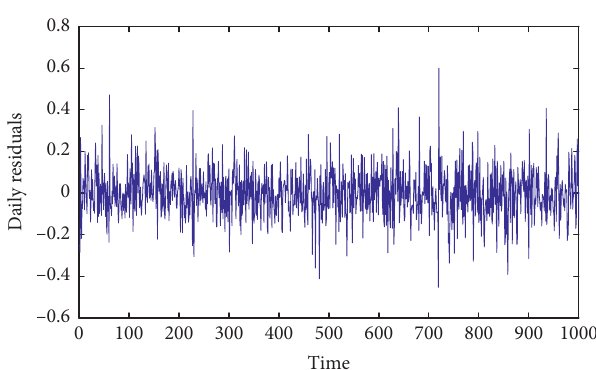
Figure 15: The simulated residual series.